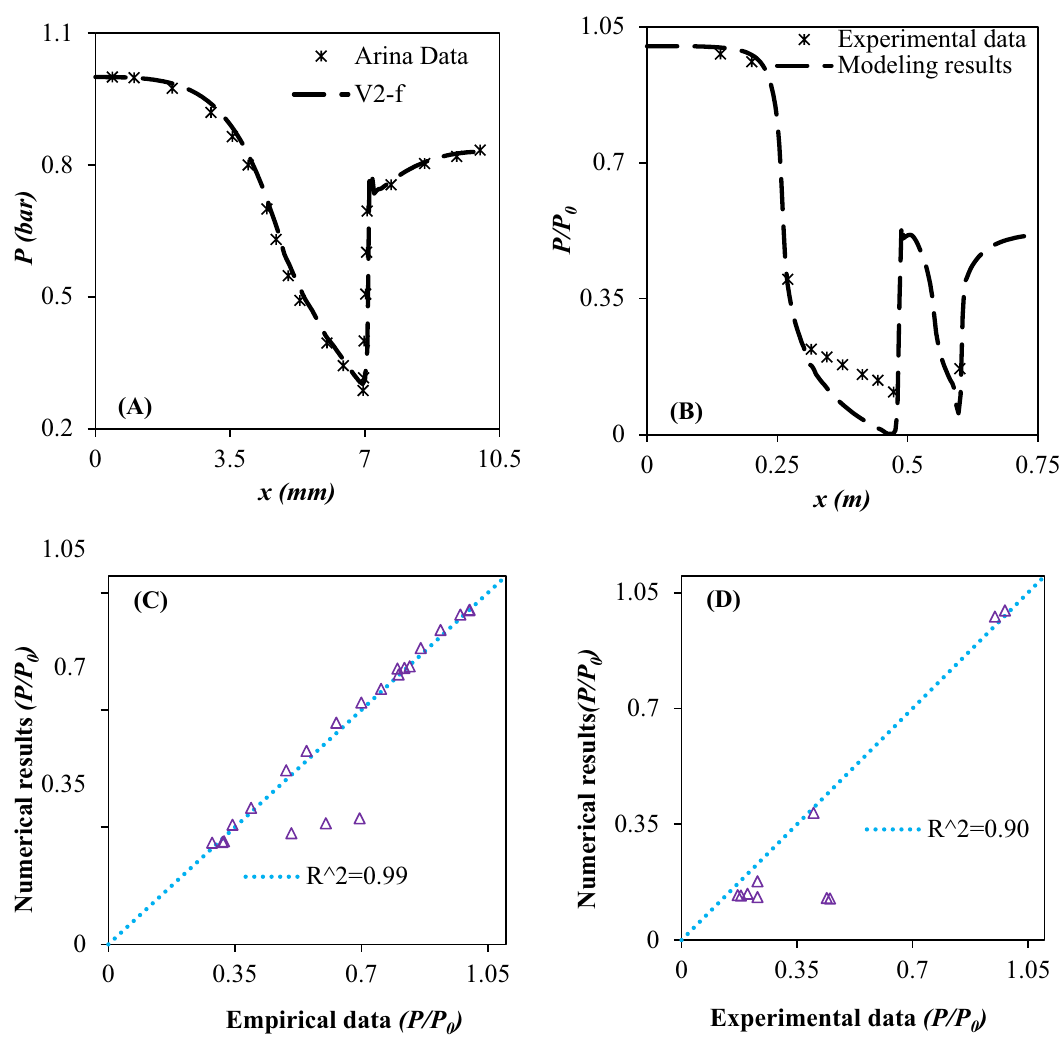
Figure 5. ( A, B ) Comparison between CFD modeling prediction and empirical data 71,73 , ( C, D ) Error analysis using root-mean-square ( R 2 )